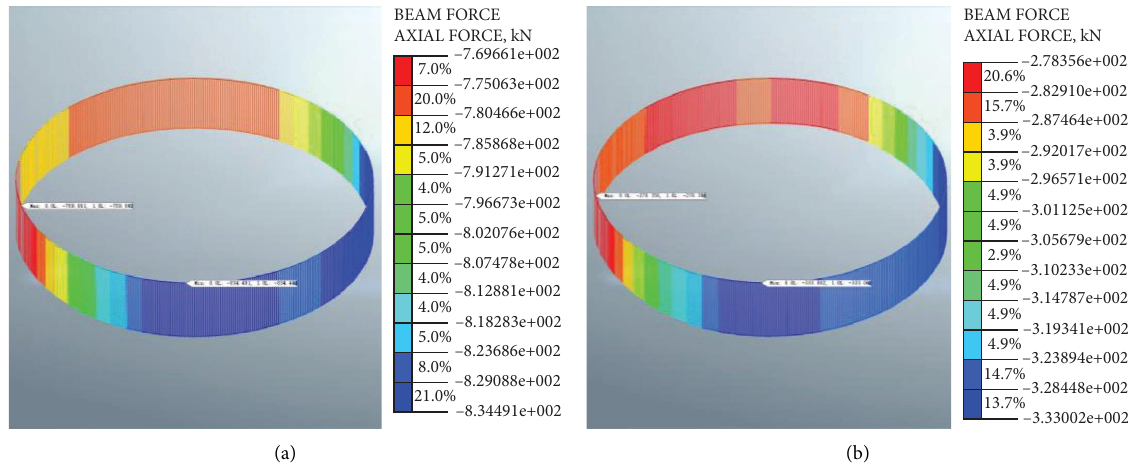
Figure 29: Working condition 2 lining axial force (a) without pore water pressure and (b) with pore water pressure